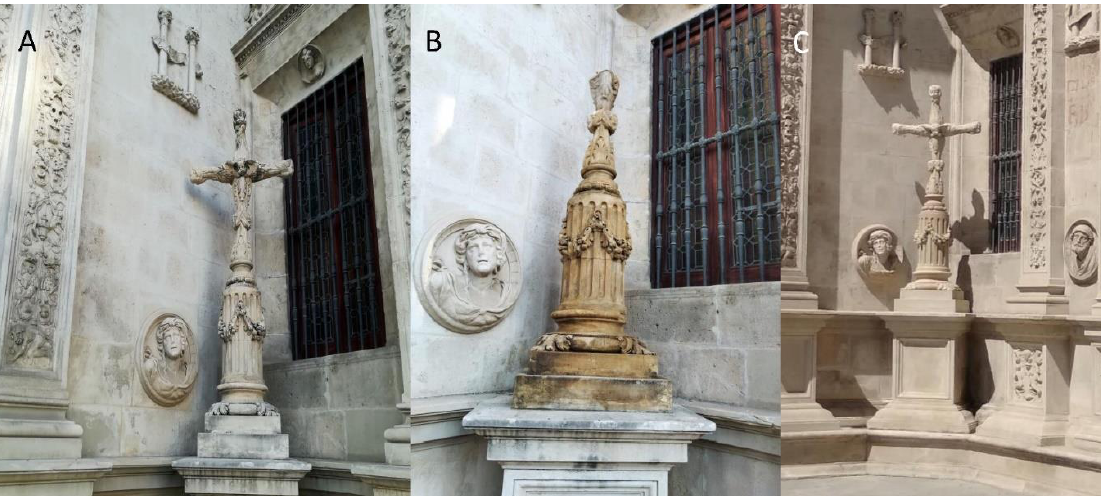
Figure 1. The Cross of the Inquisition before ( A ), after the vandalism ( B ), and restored ( C